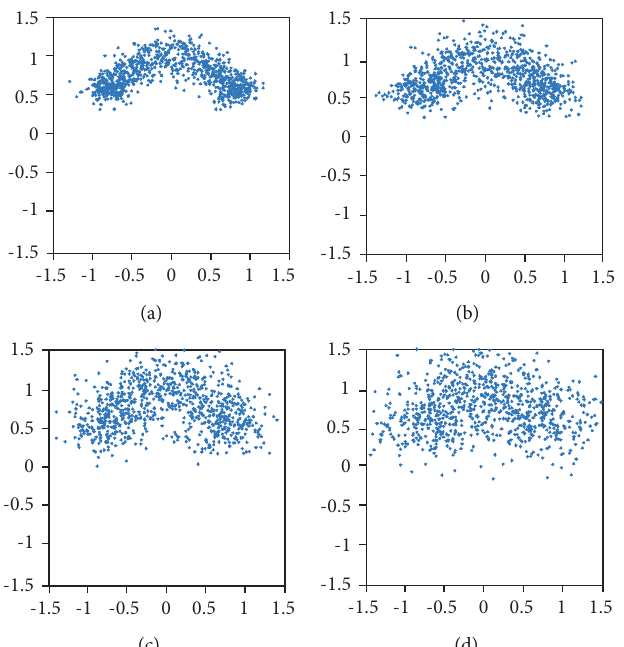
Figure 2: The constellations for simulated signal with di ff erent SNR: (a) SNR = 13dB , (b) SNR = 10 dB , (c) SNR = 7dB , and (d) SNR = 5 dB .